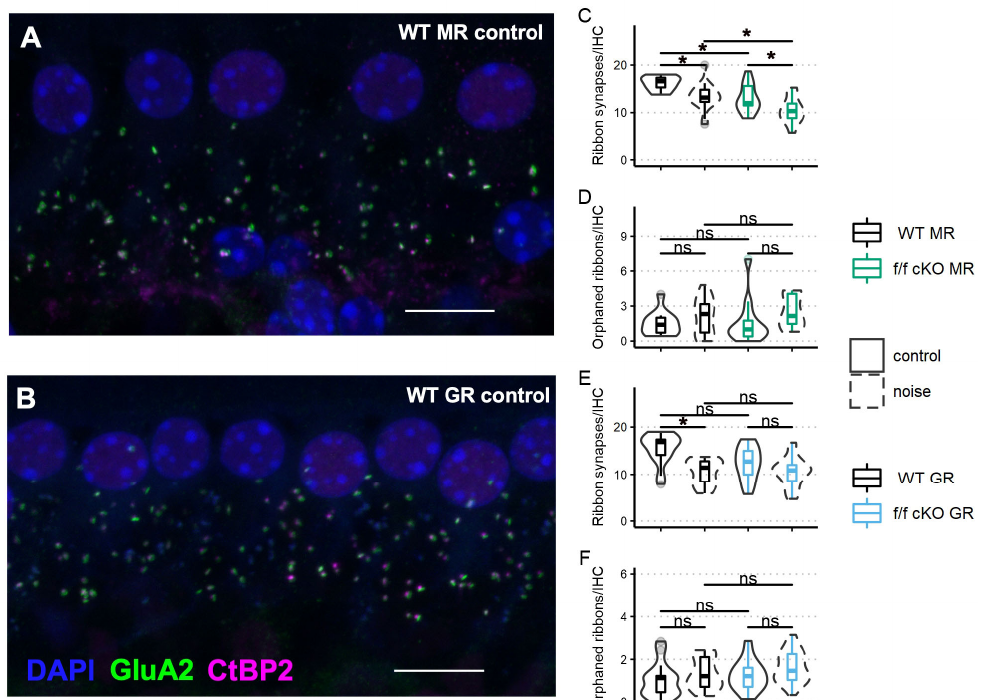
Figure 7. Ribbon synapse and orphaned ribbon counts per inner hair cell in the approximate 22 kHz region from mice at 21 dpn and from age-matched controls. Representative images of inner hair cell ribbon synapse staining from a control (no tamoxifen) MR mouse ( A ) and a control (no tamoxifen) GR mouse ( B ) are shown. ( C ) Paired CtBP2 ‐ GluA2 counts averaged over inner hair cells imaged from fMR:Sox9iCre mice. ( D ) Orphaned CtBP2 counts per inner hair cell averaged over inner hair cells imaged from fMR:Sox9iCre mice. ( E ) Paired CtBP2 ‐ GluA2 counts averaged over inner hair cells imaged from fGR:Sox9iCre mice. ( F ) Orphaned CtBP2 counts per inner hair cell averaged over inner hair cells imaged from fGR:Sox9iCre mice. Scale bar = 10 μ m. Magenta: CtBP2, green: GluA2, blue: DAPI. Linear mixed effects models were employed for data plotted in C ‐ F. Multiple comparisons were with Tukey correction. Significance (*) is p < 0.05 and ns indicates “not significant”. 2.5. Effects of GR and MR Ablation on Innate Immune Cell Presence near the Organ of Corti under Basal and Noise ‐ Exposure Conditions Iba1 + microglia, macrophage ‐ like glial cells of the CNS, are classically described in one of two morphological phenotypes. Ramified microglia are considered to be surveil ‐ ling their environment. These cells typically retract their processes and attain an ameoboid shape when a physical injury occurs and in this form function as macrophages, phagocy ‐ tosing cellular debris. However, while not producing overt pathology, stressful events are